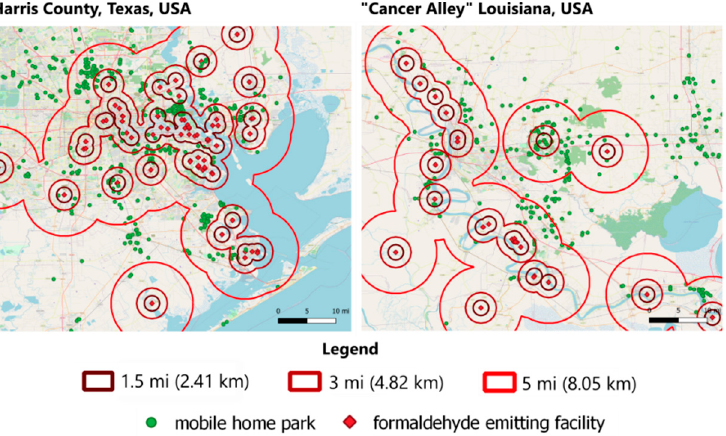
Figure 4. Density of mobile home parks near facilities releasing formaldehyde (between 2000–2018, USEPA TRI) around Harris County, TX and in the I-10 corridor between New Orleans and Baton Rouge, LA—so-called “Cancer Alley” Parishes.